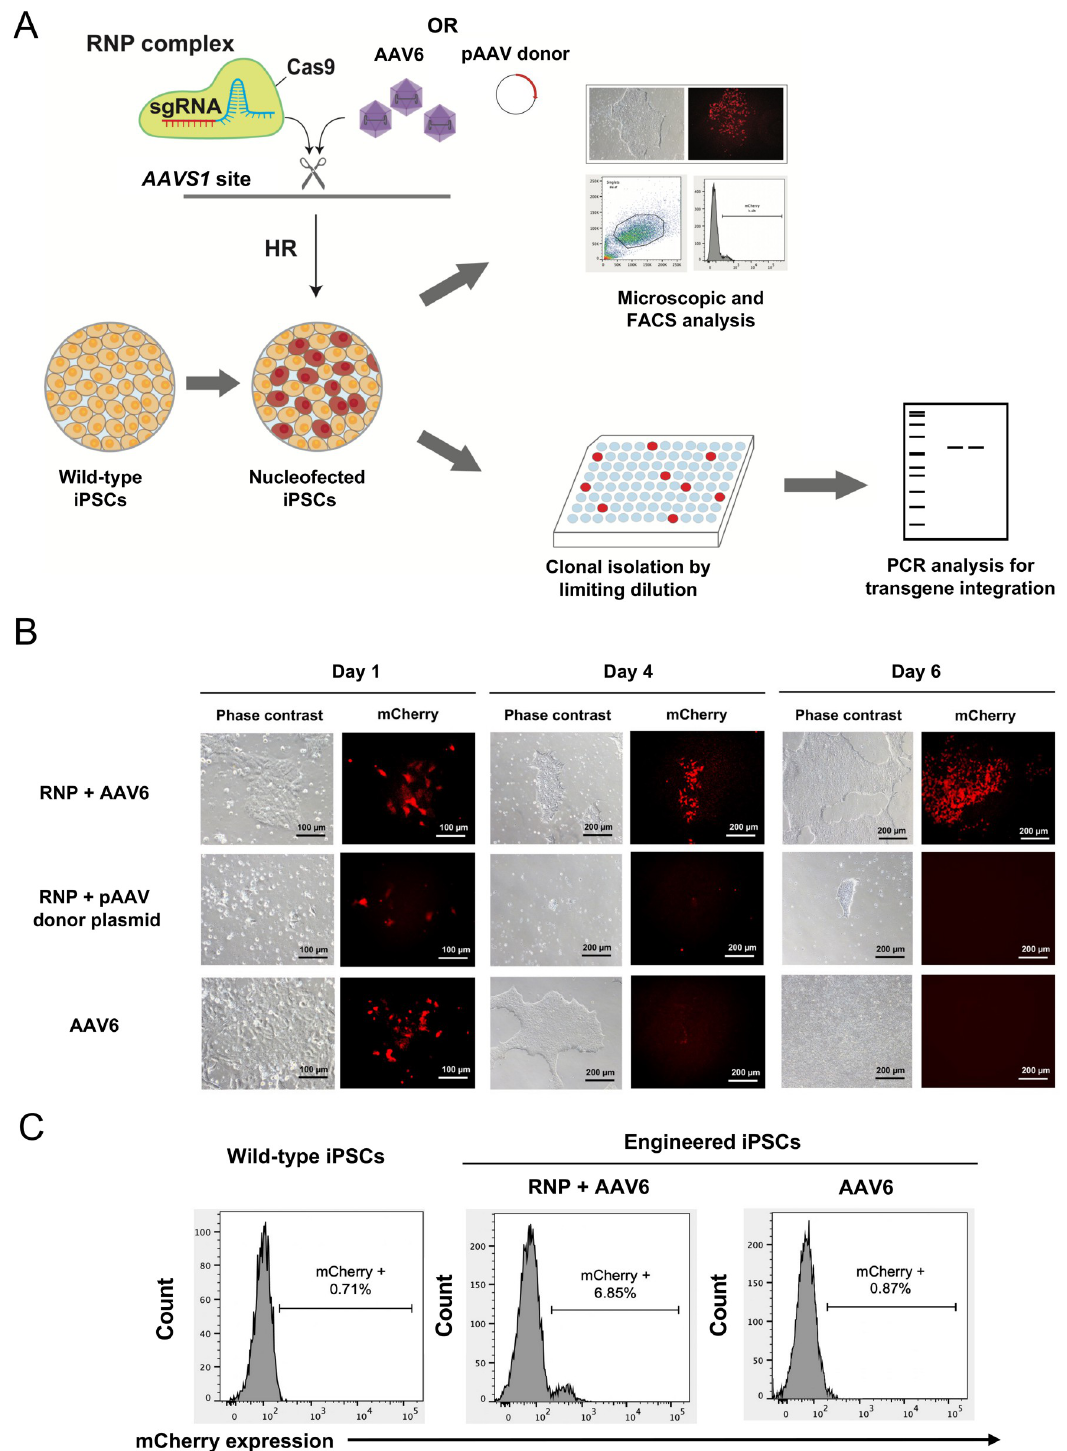
Fig 2. Nucleofection of human iPSCs. (A) Schematic diagram of the gene-editing strategy targeting the AAVS1 locus using the CRISPR/Cas9 RNP complex and the recombinant AAV6 vectors in human iPSCs. HR = Homologous Recombination. (B) Microscopic fluorescence analysis of human iPSCs shows mCherry expression on days 1, 4 and day 6 post-nucleofection from three different conditions. Scale bar = 100 μ m (Day 1) and 200 μ m (Days 4 and 6). (C) The percentage of mCherry + cells on day 6 post- nucleofection as analyzed by flow